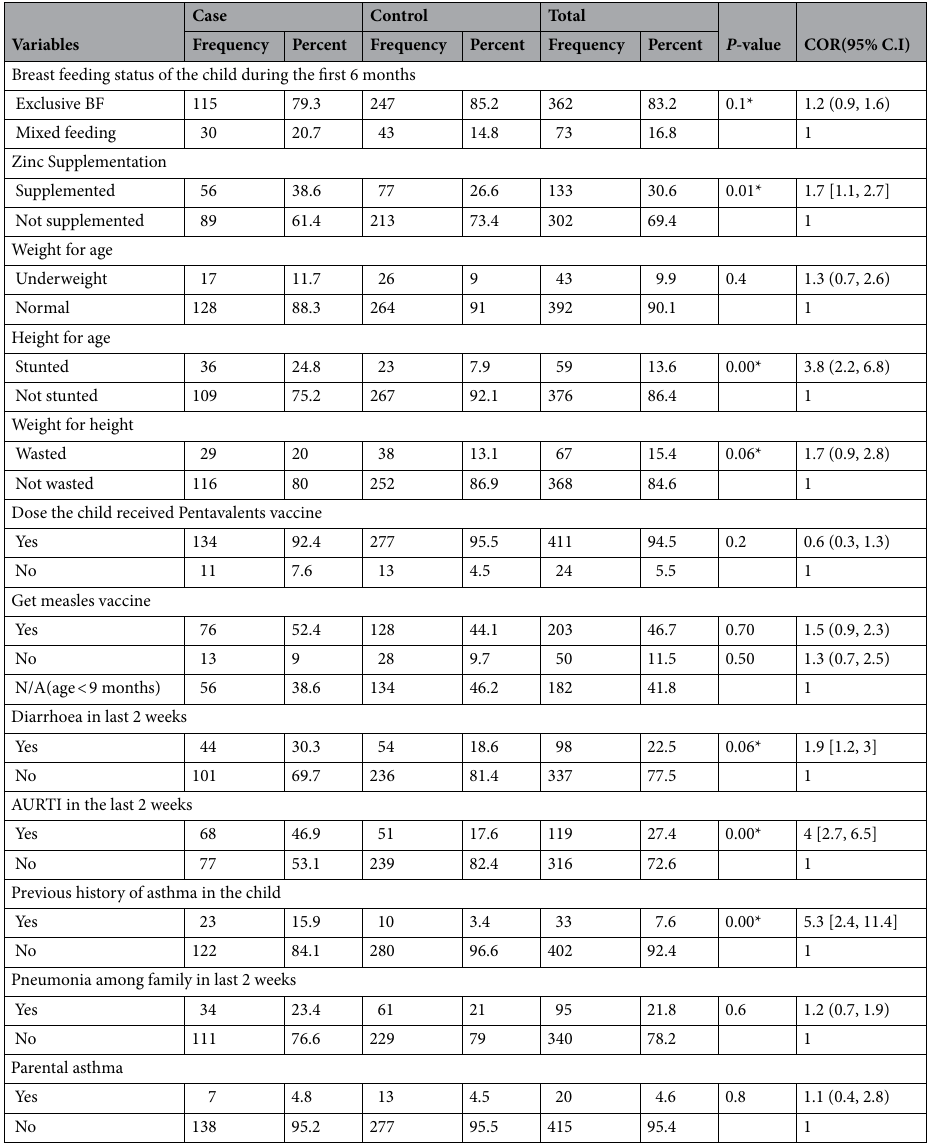
Table 2. Nutritional status, vaccination status and pre-existing illness among children aged 2–59 months attending public health facilities in Worabe town, Silte zone, 2017 (N = 145 cases and 290 controls). BF breast feeding, COR crude odds ratio, CI confidence interval, 1 reference